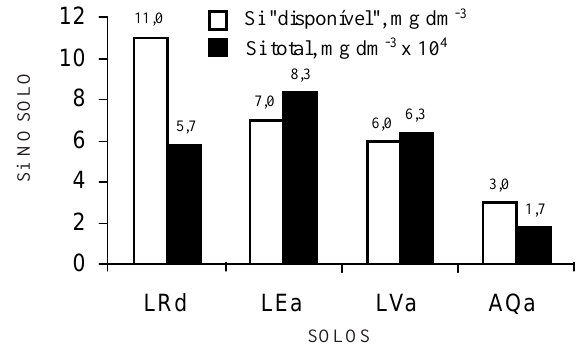
Figura 3. Relação entre o Si total da fração argila (ataque sulfúrico) e o Si “disponível” nos solos Latossolo Roxo distrófico (LVd), Latossolo Vermelho-Escuro álico (LEa), Latossolo Vermelho-Amarelo álico (LVa) e Areia Quartzosa álica